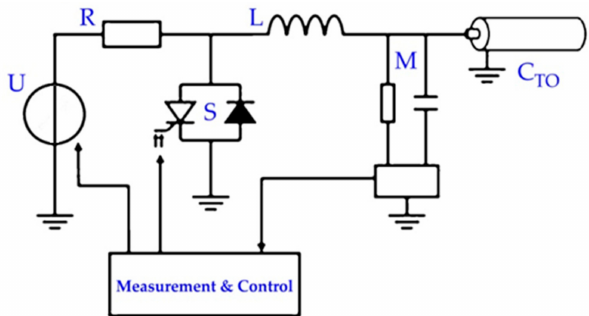
Figure 2. Schematic overview of a damped AC (DAC) system connected to a power cable, with U the high voltage source, R the protective resistor, S the semiconductor switch, L the air core inductor, M the voltage divider, and coupling capacitor and C TO the cable under test.